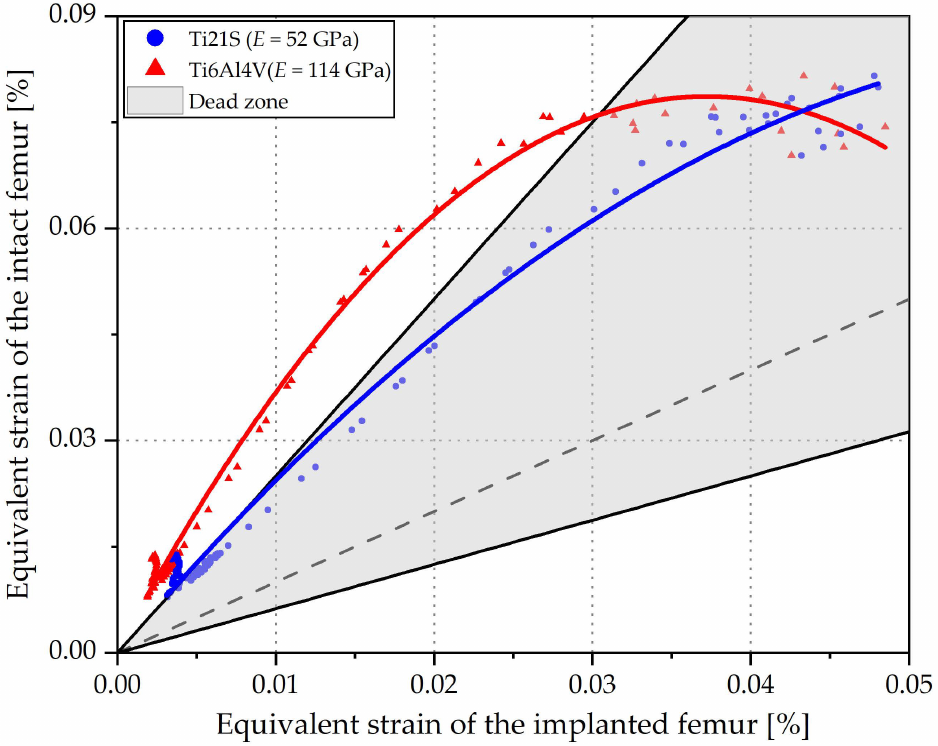
Figure 15. Influence of the modulus of elasticity of the stem